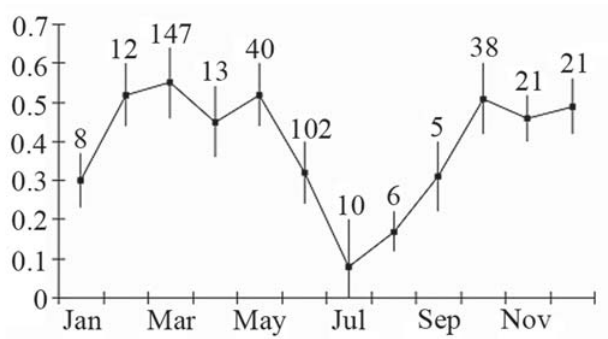
Fig. 4. Mean marginal increment ratio (± standard deviation) by month for T. obesus from northeastern Brazil.